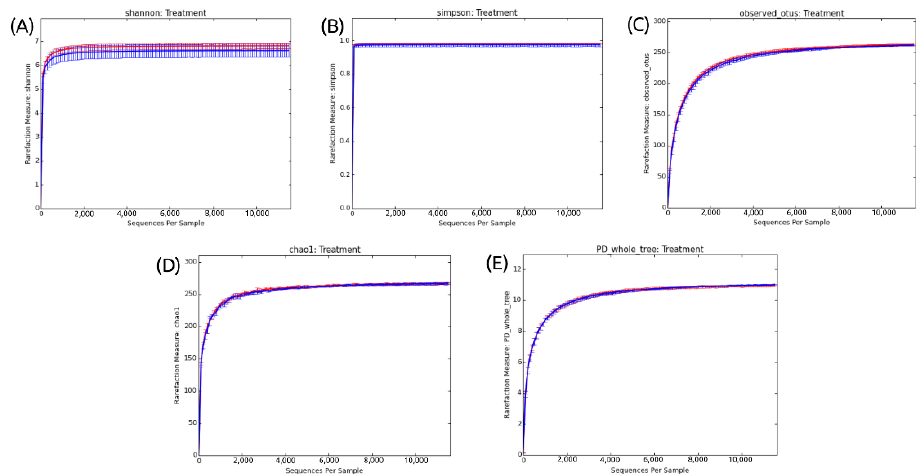
Figure 2. Alpha diversity metric indexes and number of OTUs in the fipronil and control groups. ( A ) Stabilization of the rarefaction curves for the Shannon index. ( B ) Stabilization of the rarefaction curves for the Simpson index. ( C ) Stabilization of the rarefaction curves for the number of OTUs. ( D ) Stabilization of the rarefaction curves for the Chao1 index. ( E ) Stabilization of the rarefaction curves for the Phylogenetic Diversity Whole Tree index. Rarefaction curve generated using QIIME. The rarefaction curves used a step size of 100. The control is plotted in red, and the fipronil is plotted in blue.